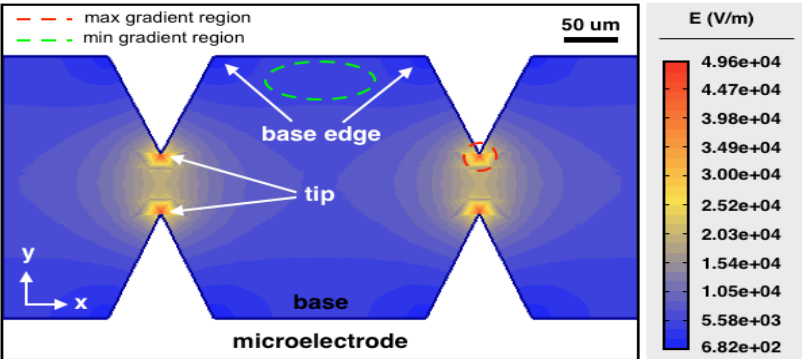
Figure 10. Simulation of electric field distribution where the dimensions used for the microelectrode design were as described in Figure 7.